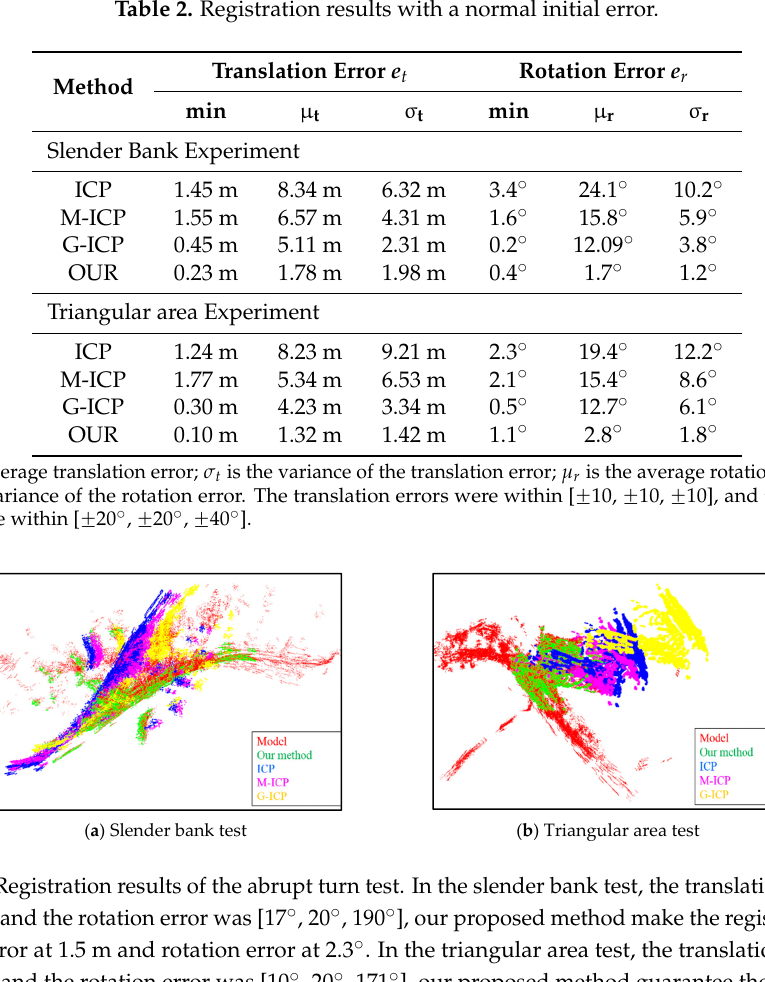
Table 3. Registration results with an abrupt turn.